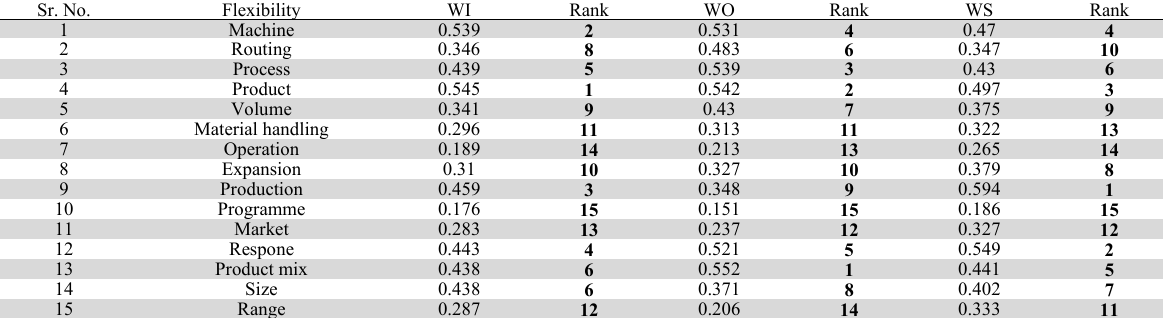
Ranking of flexibility Sr. No. Flexibility